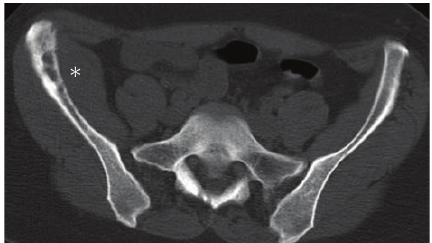
Figure 7: Lymphoma. A 30-year-old male with lymphoma. Axial CT scan illustrating permeative lesion of the right ilium with associated large soft tissue mass (asterisk) and relatively intact intervening cortex, a hallmark of small round blue cell tumors like lymphoma.